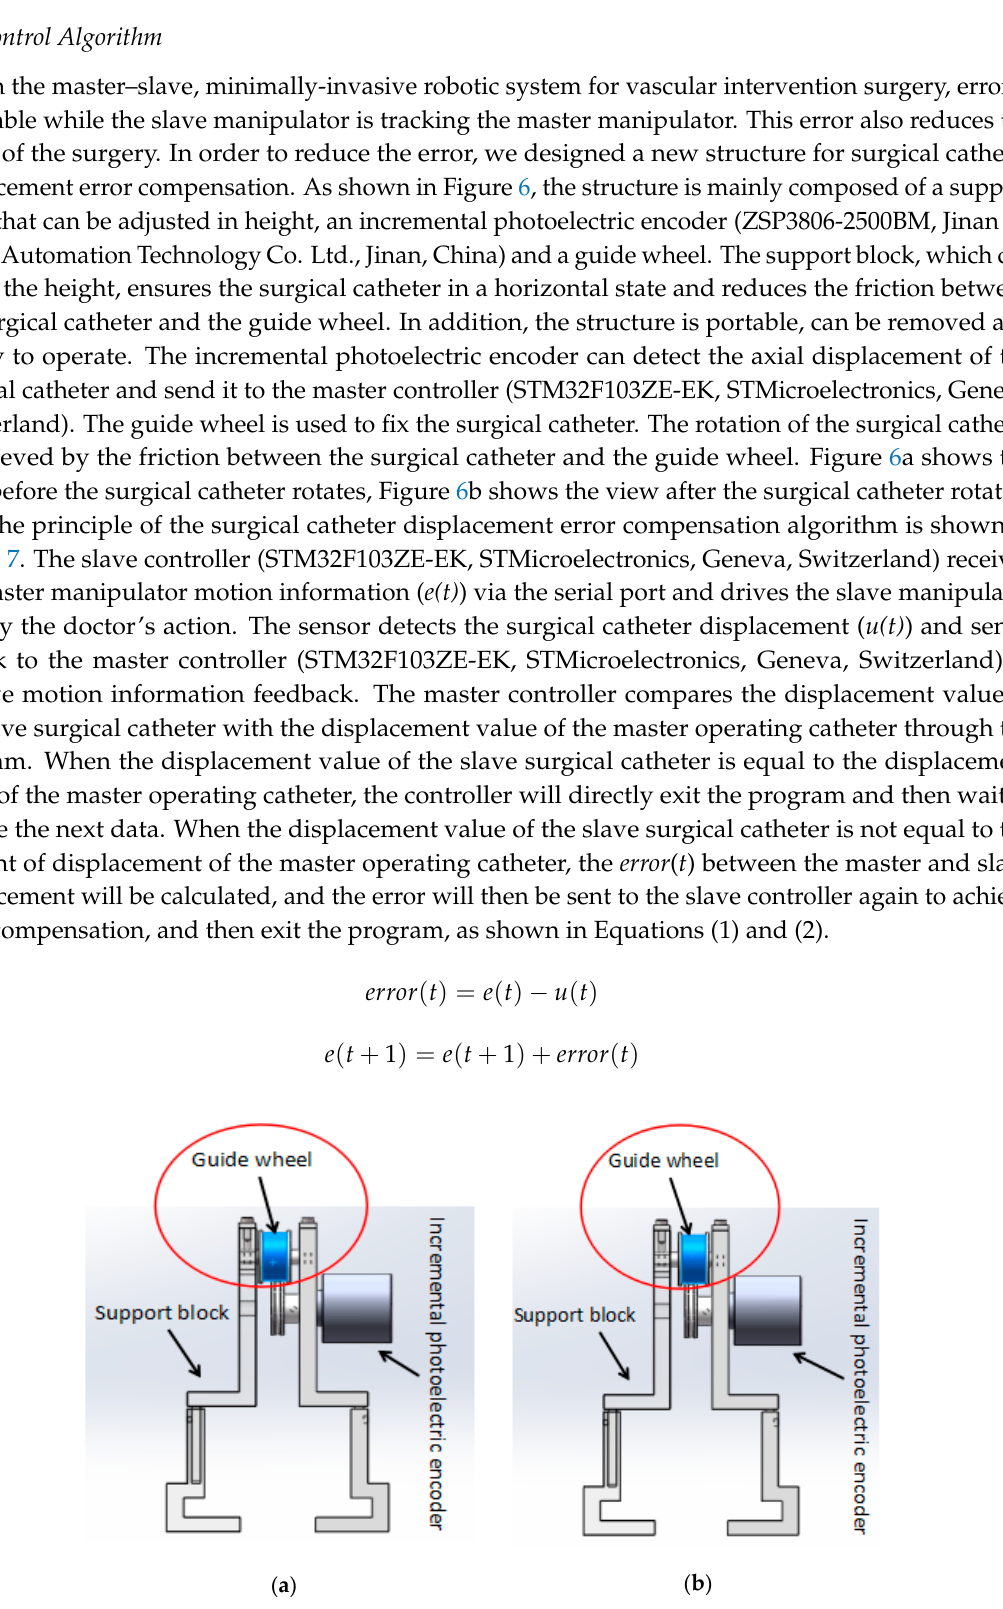
Figure 6. The structure of the surgical catheter displacement error compensation ( a ) before the surgical catheter is rotated; ( b ) after the surgical catheter is rotated.